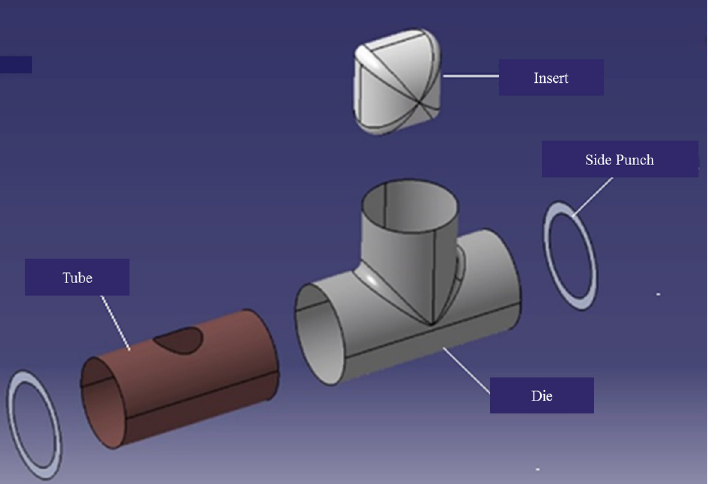
Fig 9. Computer-aided design (CAD)